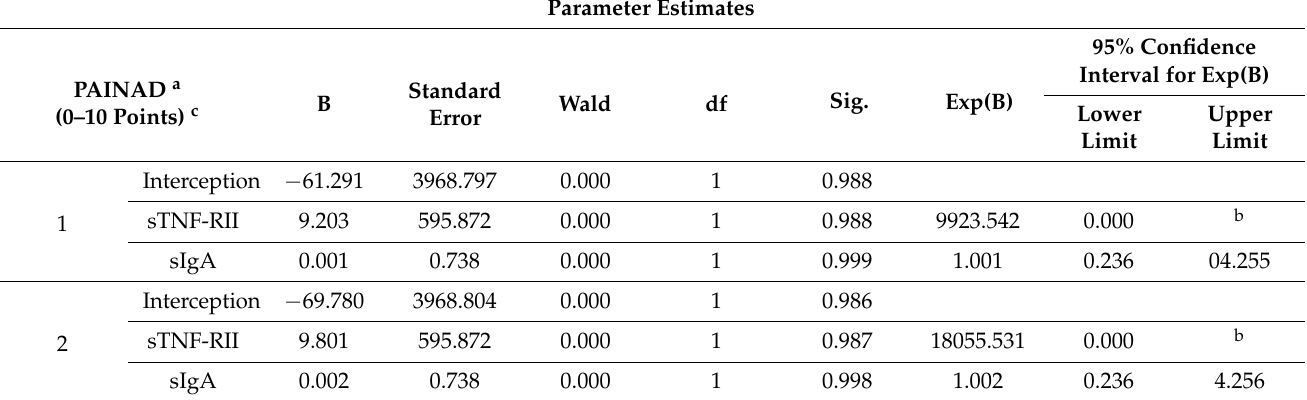
Table 5. Multivariate logistic model between the original PAINAD score and sTNF-RII and